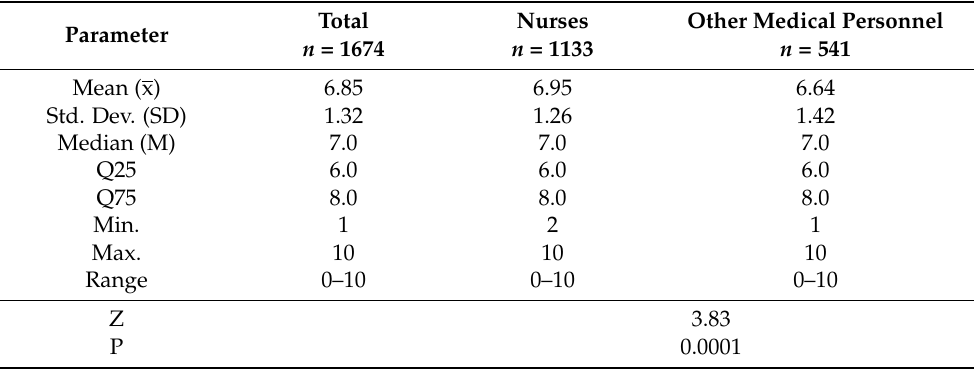
Table 2. Descriptive statistics of the respondents’ knowledge level by occupation and the Mann– Whitney U-test results (Z).